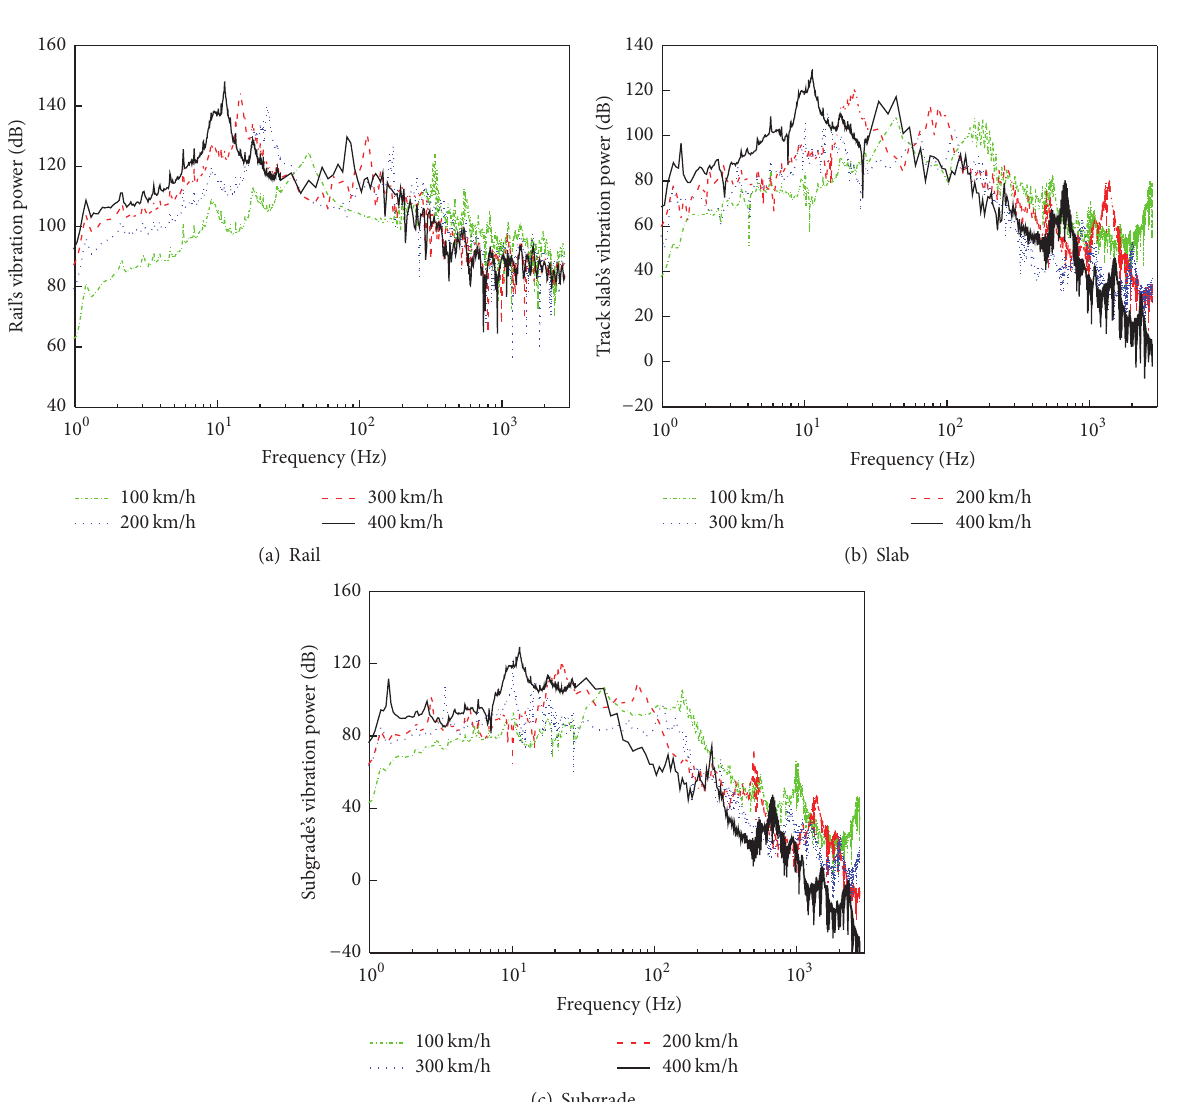
Figure 11: The effect of vehicle speed on the vibration power of track and subgrade